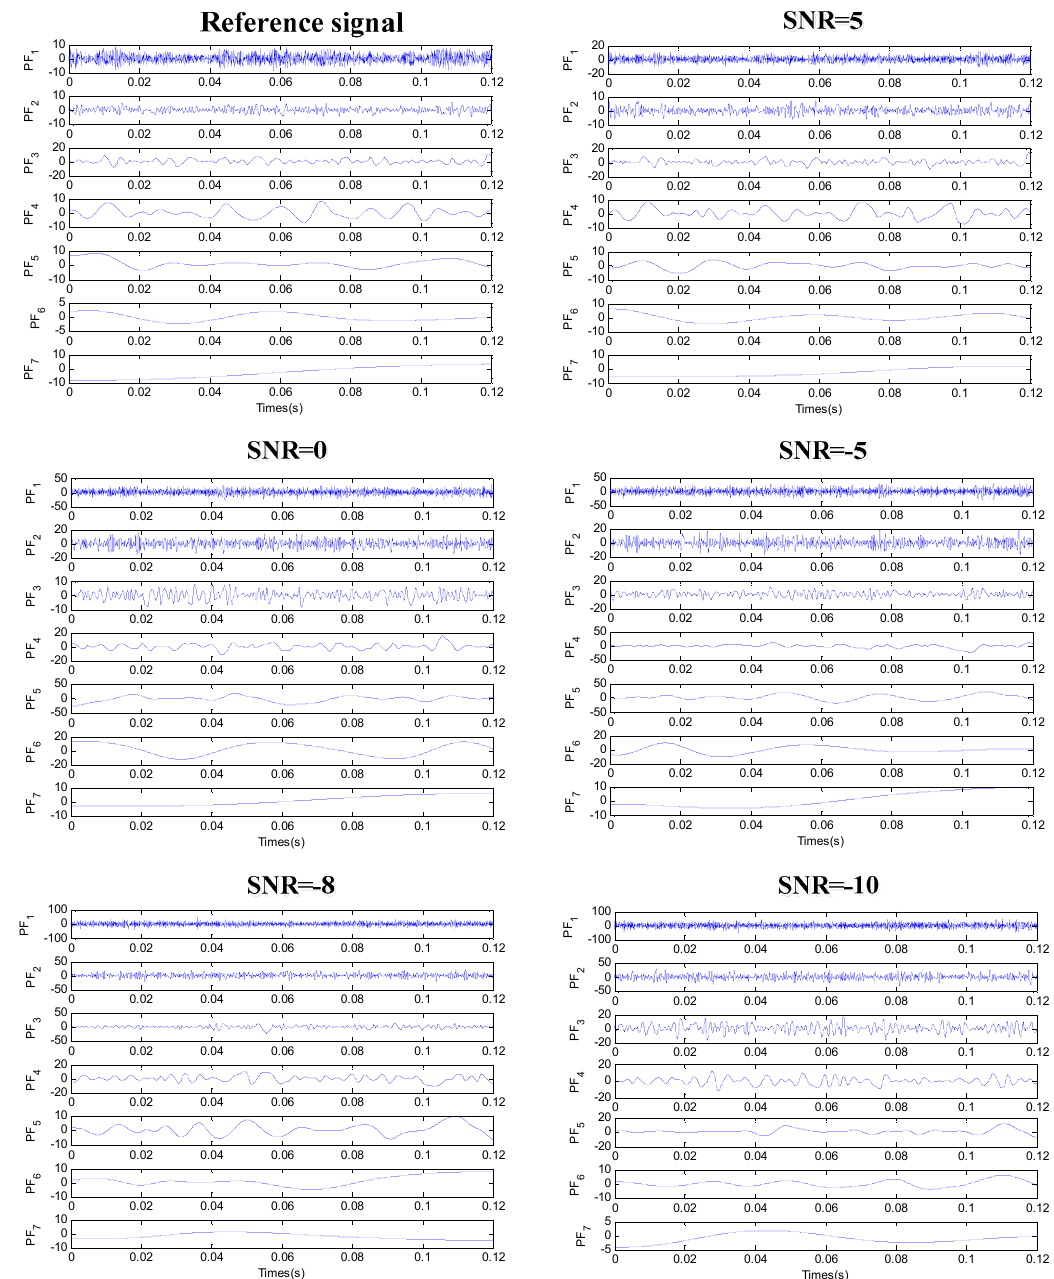
Figure 7. PF components after the decomposition of different noise signals.